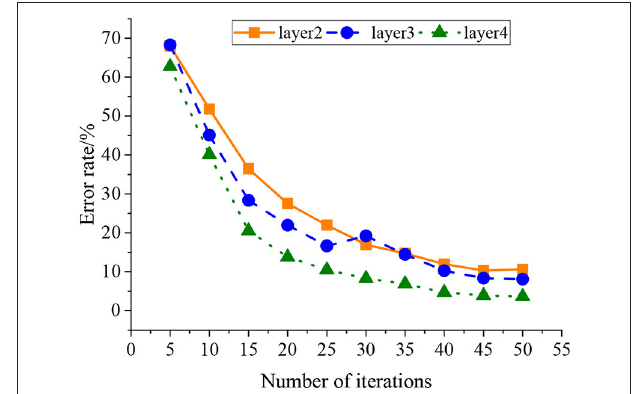
FIGURE 7 | The training process of each layer of the HNN model.